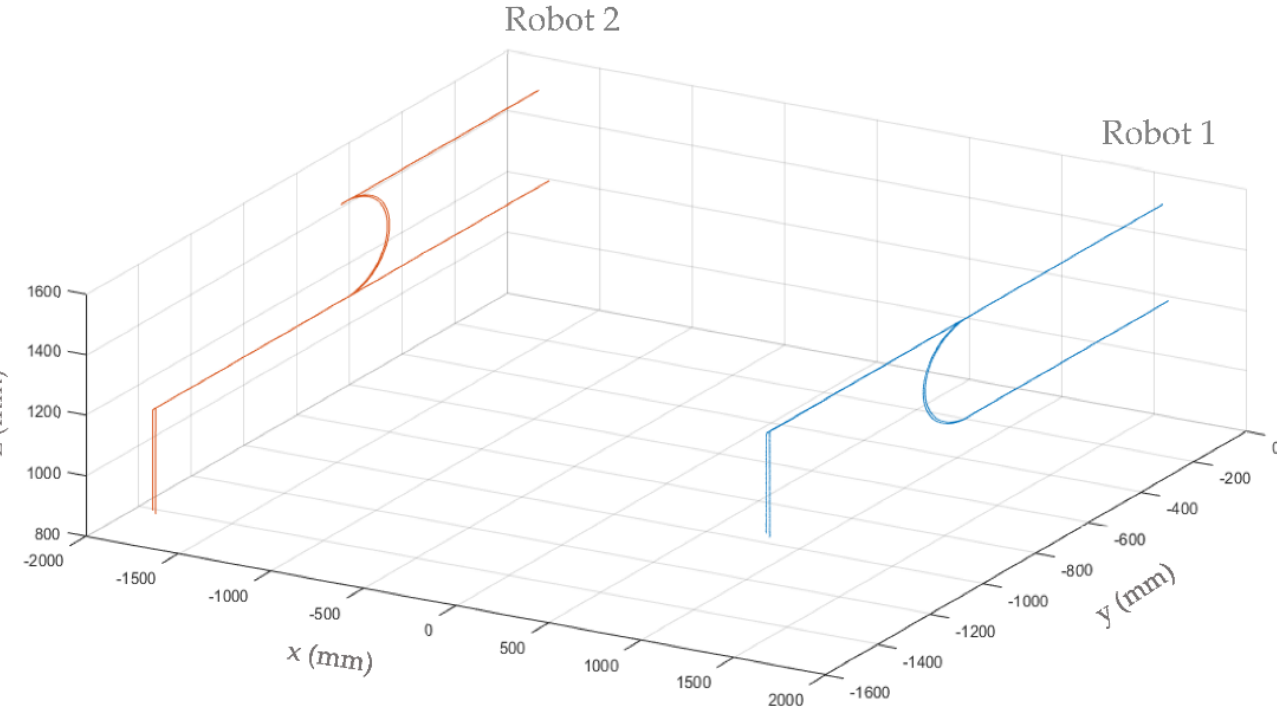
Figure 11. The trajectory paths followed by the grasping points for the dummy